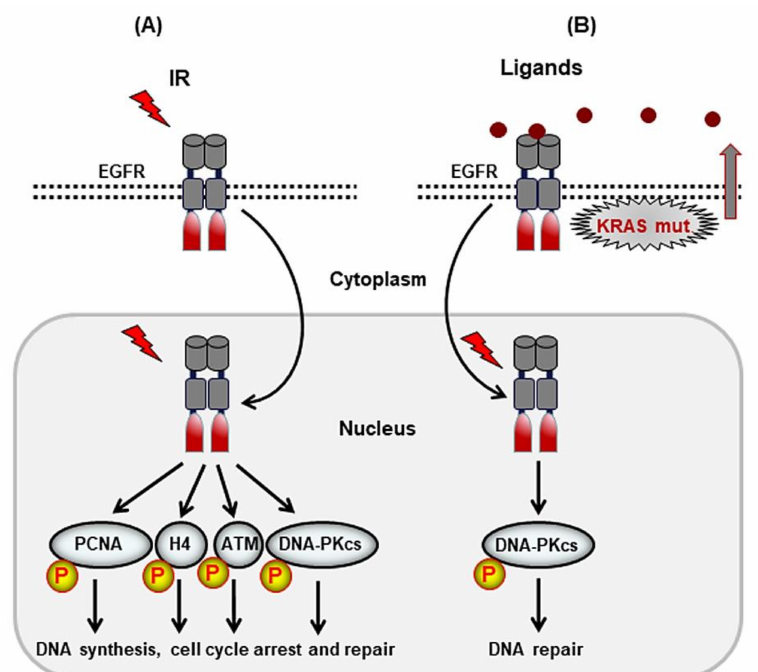
Figure 2. Overview of potential mechanisms by which epidermal growth factor (EGFR) stimulates DNA double-strand break repair, leading to radioresistance. ( A ) Ionizing radiation (IR) stimulates membrane-bound EGFR, which may lead to translocation of the receptor to the nucleus. Ionizing radiation may induce the activation of EGFR directly in the nucleus. ( B ) Exogenous stimulation of EGFR by related ligands, such as EGF and transforming growth factor α (TGF α ), as well as autocrine secretion of EGFR ligands, such as in tumor cells harboring the KRAS mutation, induce nuclear translocation of EGFR. Following irradiation, activated EGFR in the nucleus stimulates DNA repair machinery by stimulating the phosphorylation/activation of proteins involved in DNA damage response (DDR) and DSB repair. EGFR may also function as a transcription factor regulating proteins involved in DSB